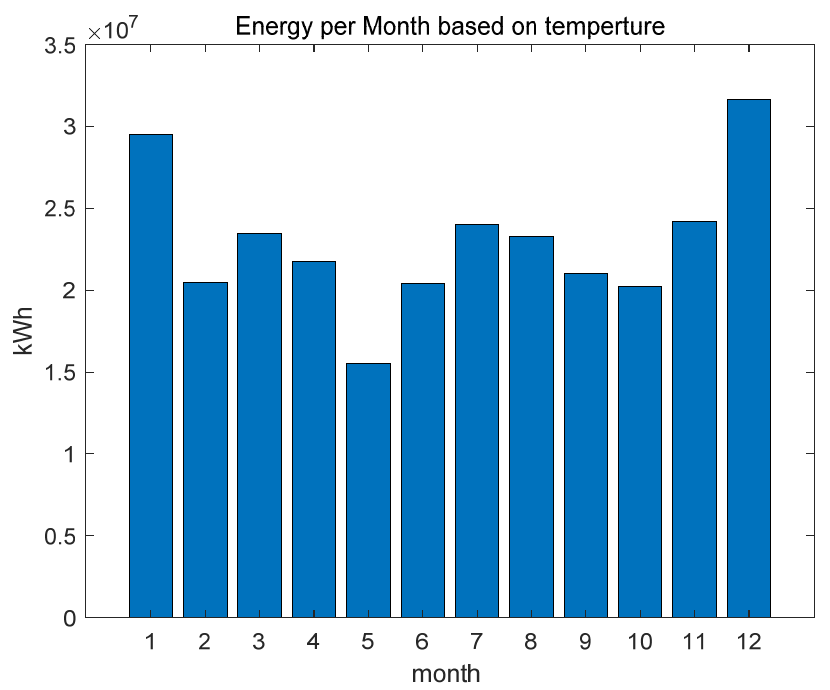
Figure 3. Annual load fluctuation trend of charging